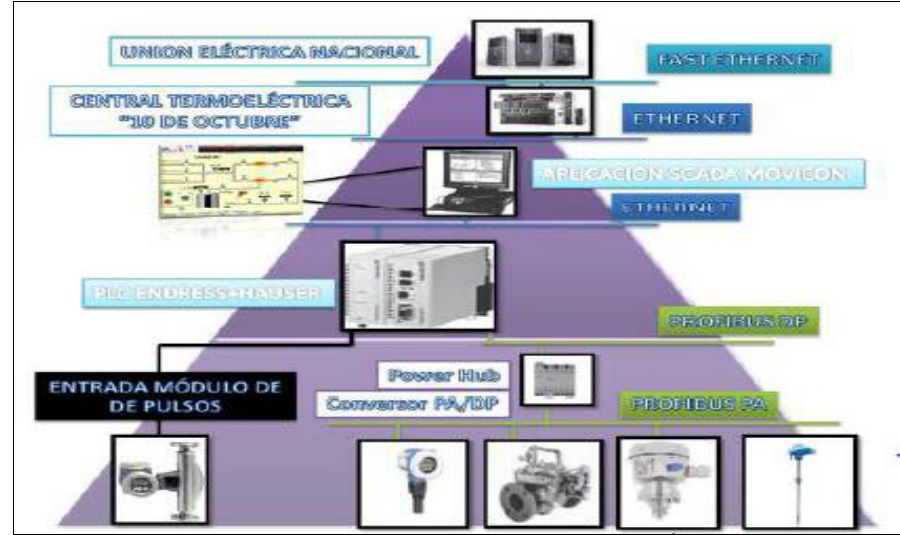
Figura 16: Pirámide de Automatización de un subsistema del trasiego de combustible. Fuente: Los Autores,